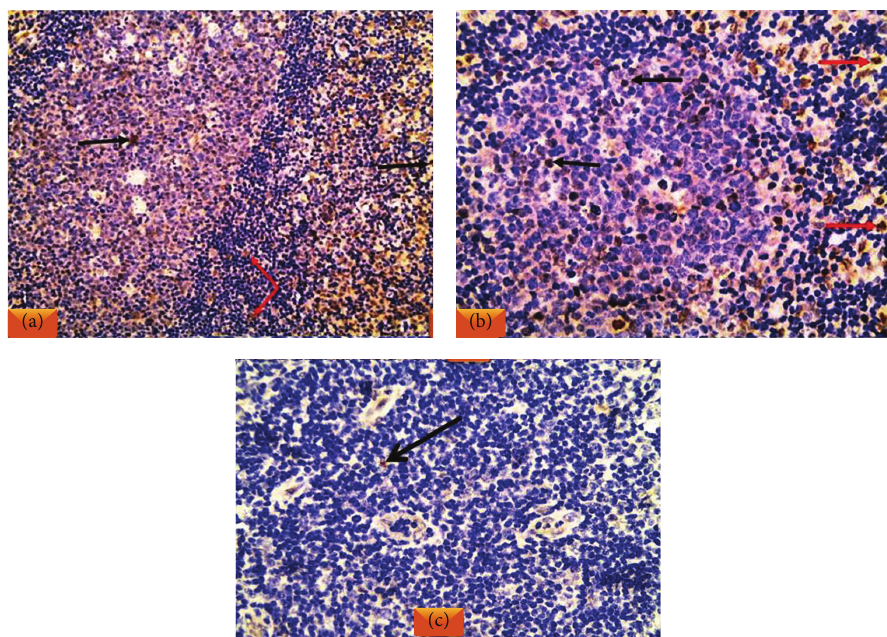
Figure 3: (a) A case of reactive follicular hyperplasia showed positive nuclear staining of E2F1 in the lymphocytes in the germinal center (black arrows) and in the interfollicular area (red arrows). (b) High power view of lymphocytes with nuclear positivity in the germinal center (black arrows) and in the interfollicular area (red arrows) together with negative mantle zone lymphocytes. (c) A germinal center exhibited